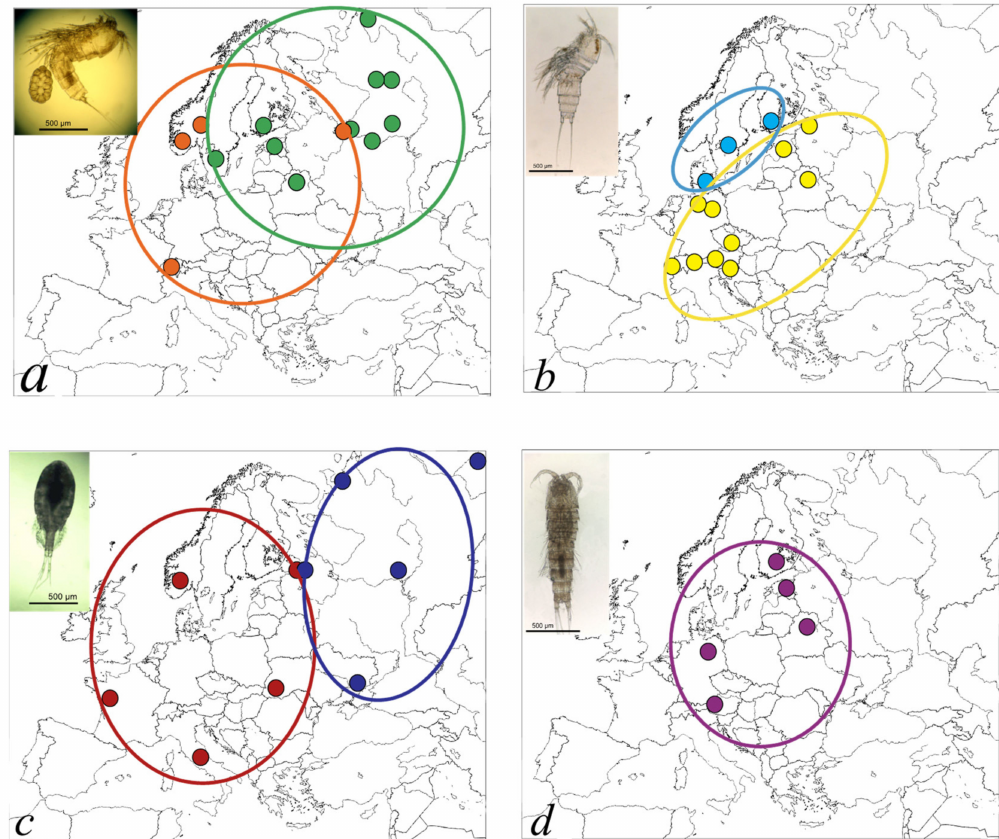
Figure 5. Maps of the sampling locations and phylogenetic clades division of A. crassa ( a ) , C. staphylinus ( b ), E. serrulatus ( c ), and Nitokra hibernica ( d ). Colors correspond with the colors of clades in the phylogenetic trees (Figures 1, 2, 3 and